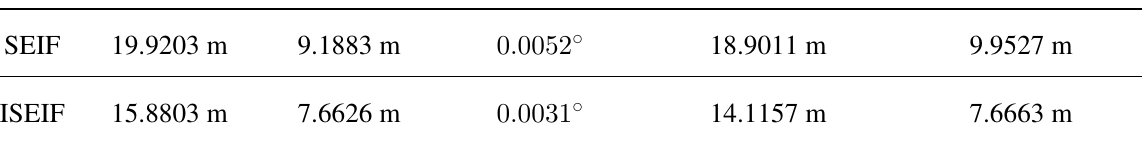
Table 2. Average errors over 50